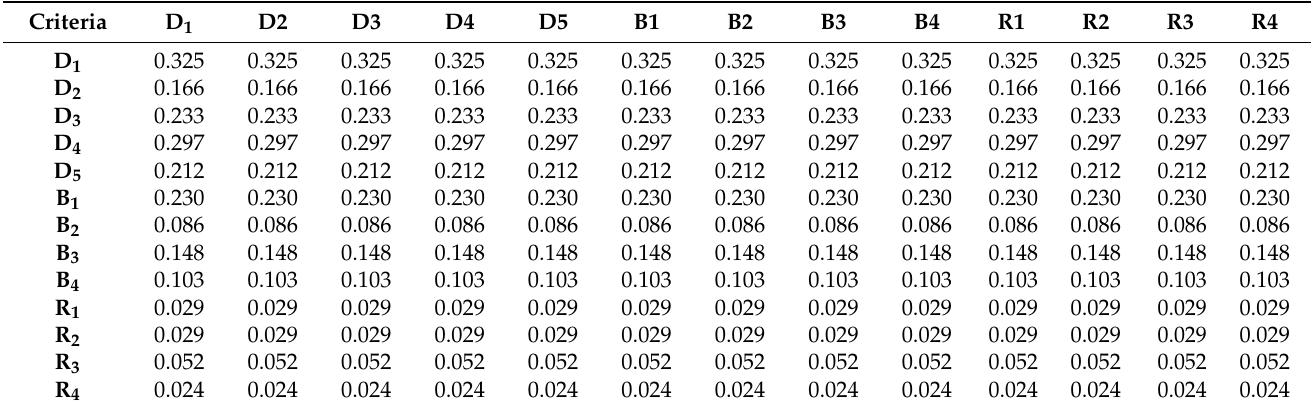
Table 5. The final generated matrix uses OWA for decision-maker judgments about driver, barrier, and risk criteria.